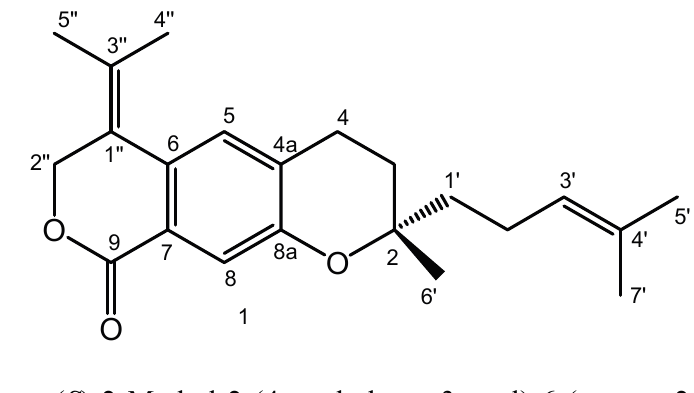
Figure 1. ( S )-2-Methyl-2-(4-methylpent-3-enyl)-6-(propan-2-ylidene)-3,4,6,7- tetrahydropyrano[4,3- g ]chromen-9(2 H )-one ( 1 ). Results and